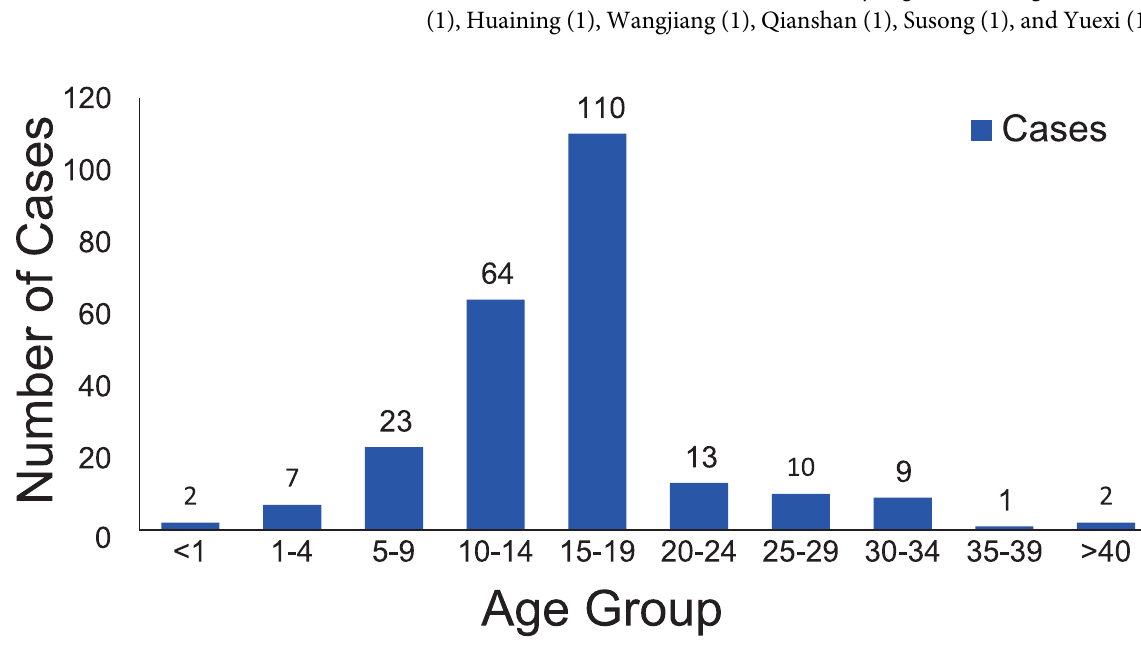
Fig 2. Number of reported rubella cases by age